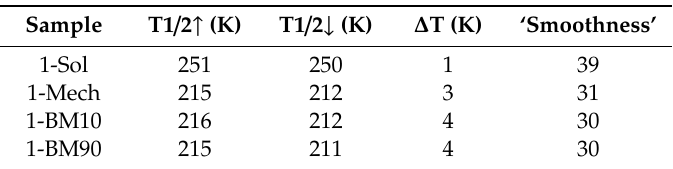
∎ Table 1. Spin crossover (SCO) properties determined by SQUID magnetometry for 1-Sol, 1-Mech, 1- BM10 and 1-BM90.